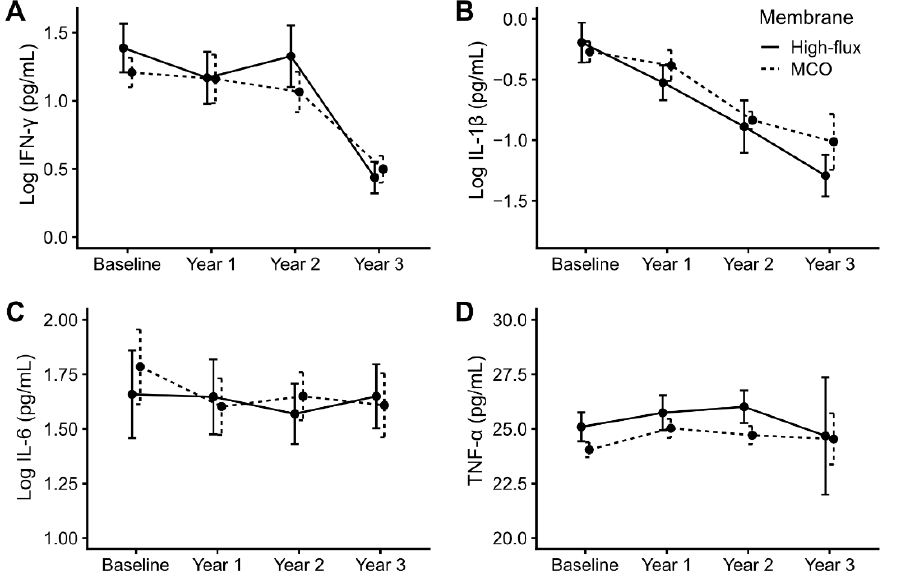
Figure 4. Changes in cytokine concentrations during the three-year treatment period according to the membrane type. The mean values of cytokines during the study periods are presented: ( A ) interferon- γ , ( B ) interleukin-1 β , ( C ) interleukin-6, ( D ) tumor necrosis factor- α . Data are presented as arithmetic means and standard errors as an error bar plot. The values of interferon- γ , interleukin-1 β , and interleukin-6 were logarithmically transformed. The values of the high-flux group are represented as solid lines and those of the MCO group as dash lines. MCO, medium cut-off; IFN interferon; IL, interleukin; TNF, tumor necrosis factor.